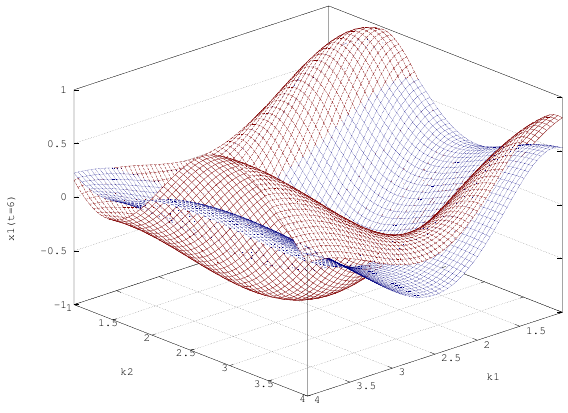
k 1 , k 2 4 with HF and LF results shown in red and blue, ≤ ≤